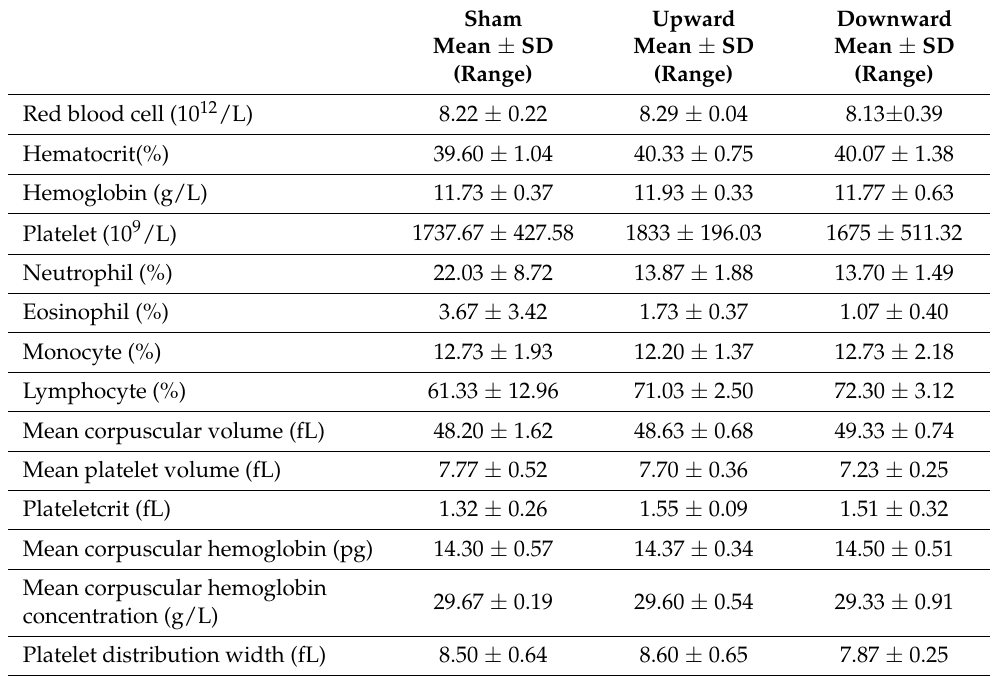
Table 1. Effects of static magnetic field exposure on complete blood count indicators in mice. Statistical analysis was performed and no significant differences were